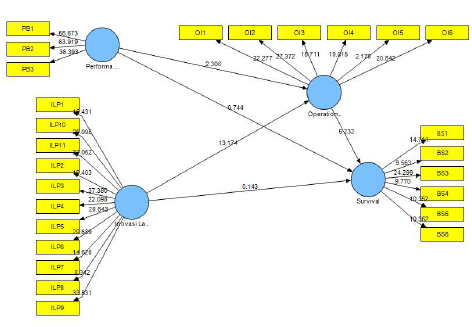
Fig. 1. The results of testing the hypotheses of the survey using SEM